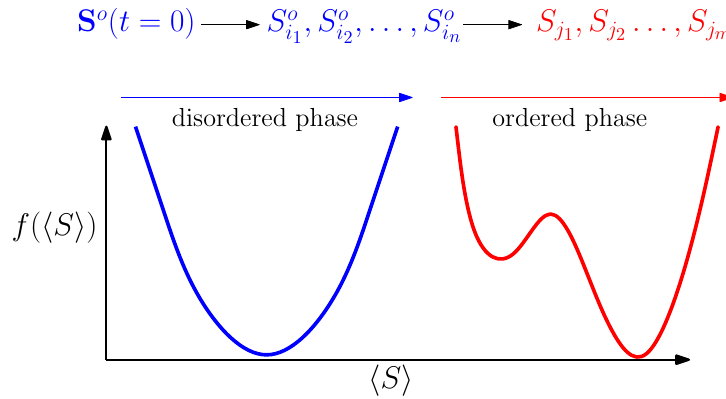
Figure 5. A diagnostic process that starts with the step-by-step approach and then switches to the batch approach after a phase transition to an ordered phase. In the disordered phase, the probability distribution of the signs is described by a single pure Gibbs state in which the observed signs on average give no information about the values of the unobserved signs. More observations can lead to a phase transition to an ordered phase in which there are multiple pure Gibbs states that provide useful information about the unobserved